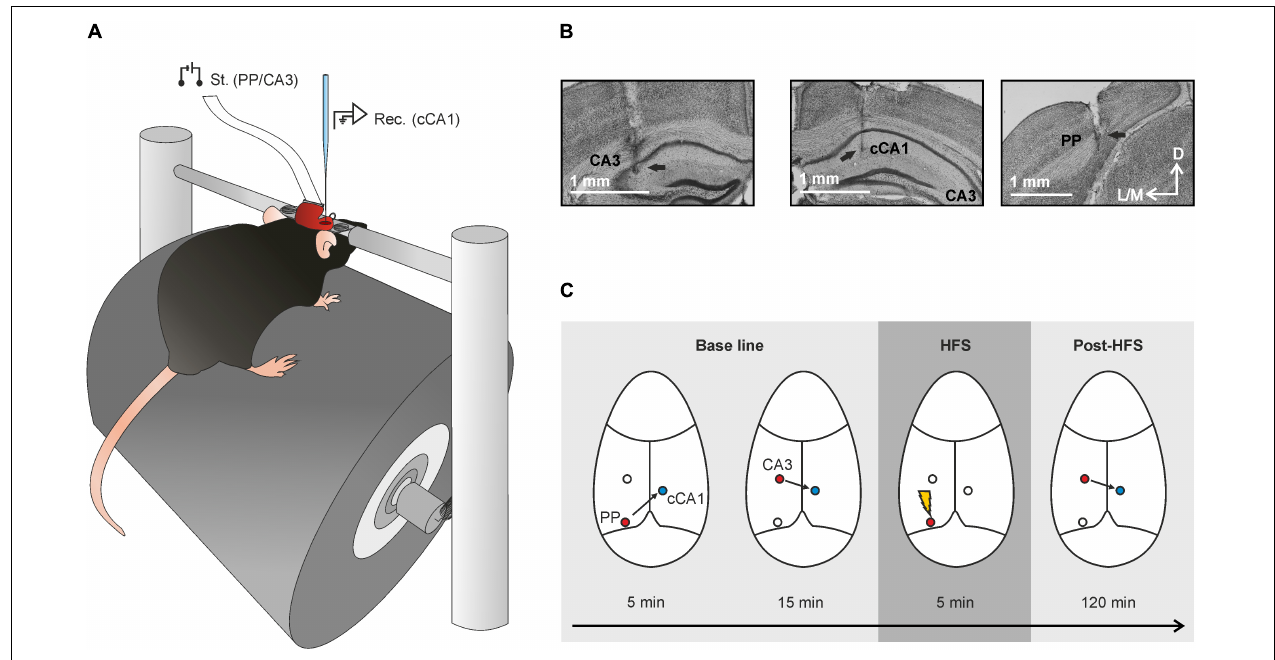
FIGURE 6 | Experimental procedures for recordings in alert head-fixed mice. (A) Mice were placed on a head-fixed set-up for the recording of cCA1 potentials evoked by stimulation of either the PP or the hippocampal CA3 area. (B) Photomicrographs of CA3, cCA1, and PP showing the electrode scar. (C) Schematic representation of the involved synapses during the experiment with indication of the stimulating (red) and recording (blue) locations. A 5-min baseline was recorded for the PP-CA3 synapse to ensure that the position of the electrode in the PP was good enough for the successive HFS, followed by a 15-min baseline for the CA3-cCA1 synapse. After the 5-min HFS, post-HFS recordings were carried out in the CA3-cCA1 synapse for 120